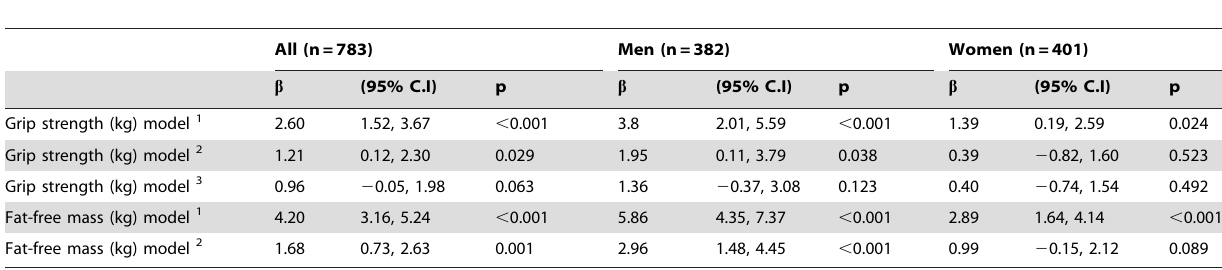
Table 2. Associations ( b –coefficients; 95% CI) between birth weight and adult hand grip strength or fat-free mass in all individuals.